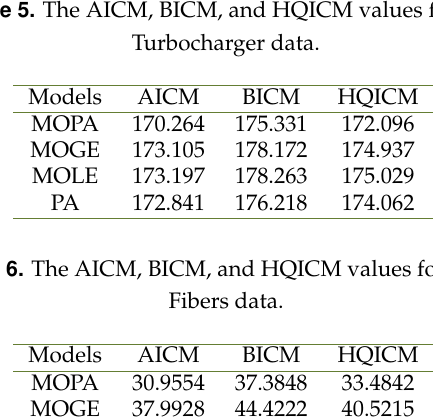
Table 4. The MLEs and their SEs in brackets for the Glass Fibers data.